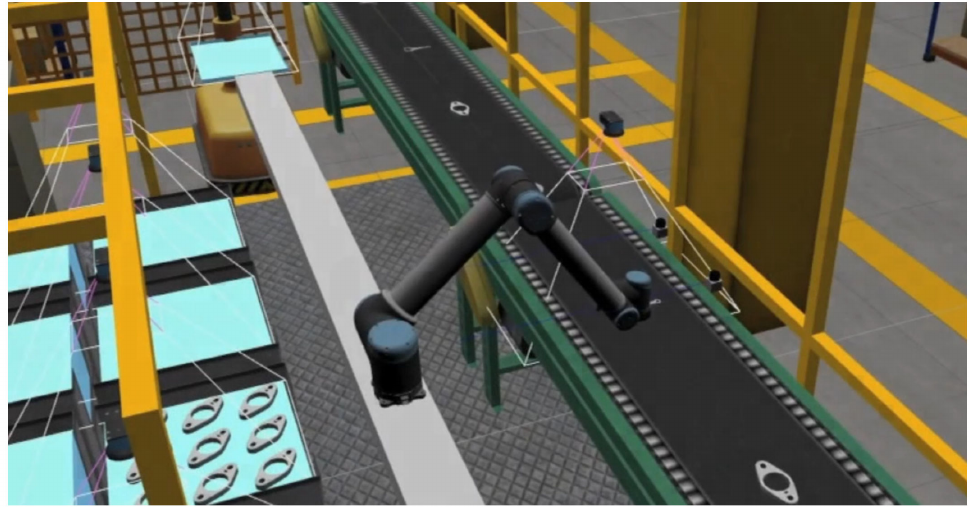
Figure 8. Sample screen from the model created for the competition ARIAC by team River Lab. Source: